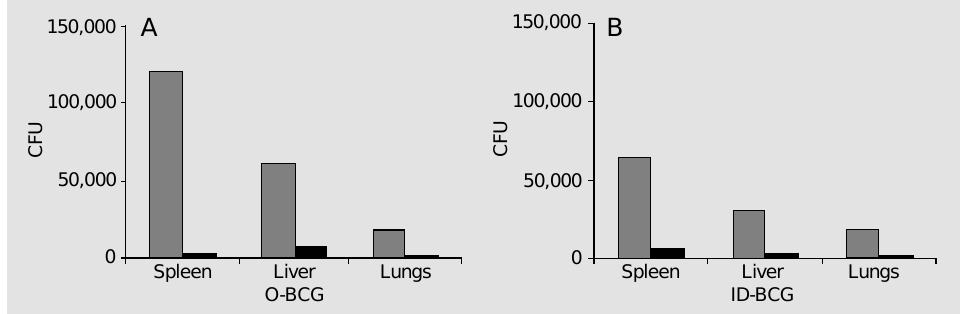
Figure 1 - Growth of BCG in nor- mal and immunized mice. Two groups of BALB/c mice (5